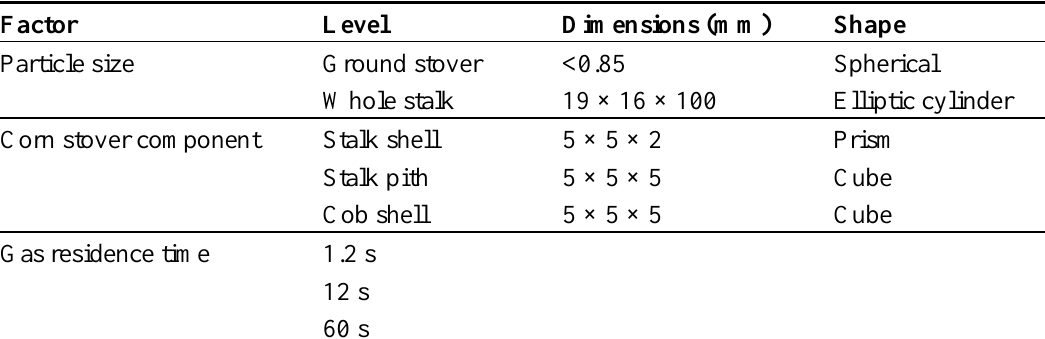
Table 1. Sample designation and basic